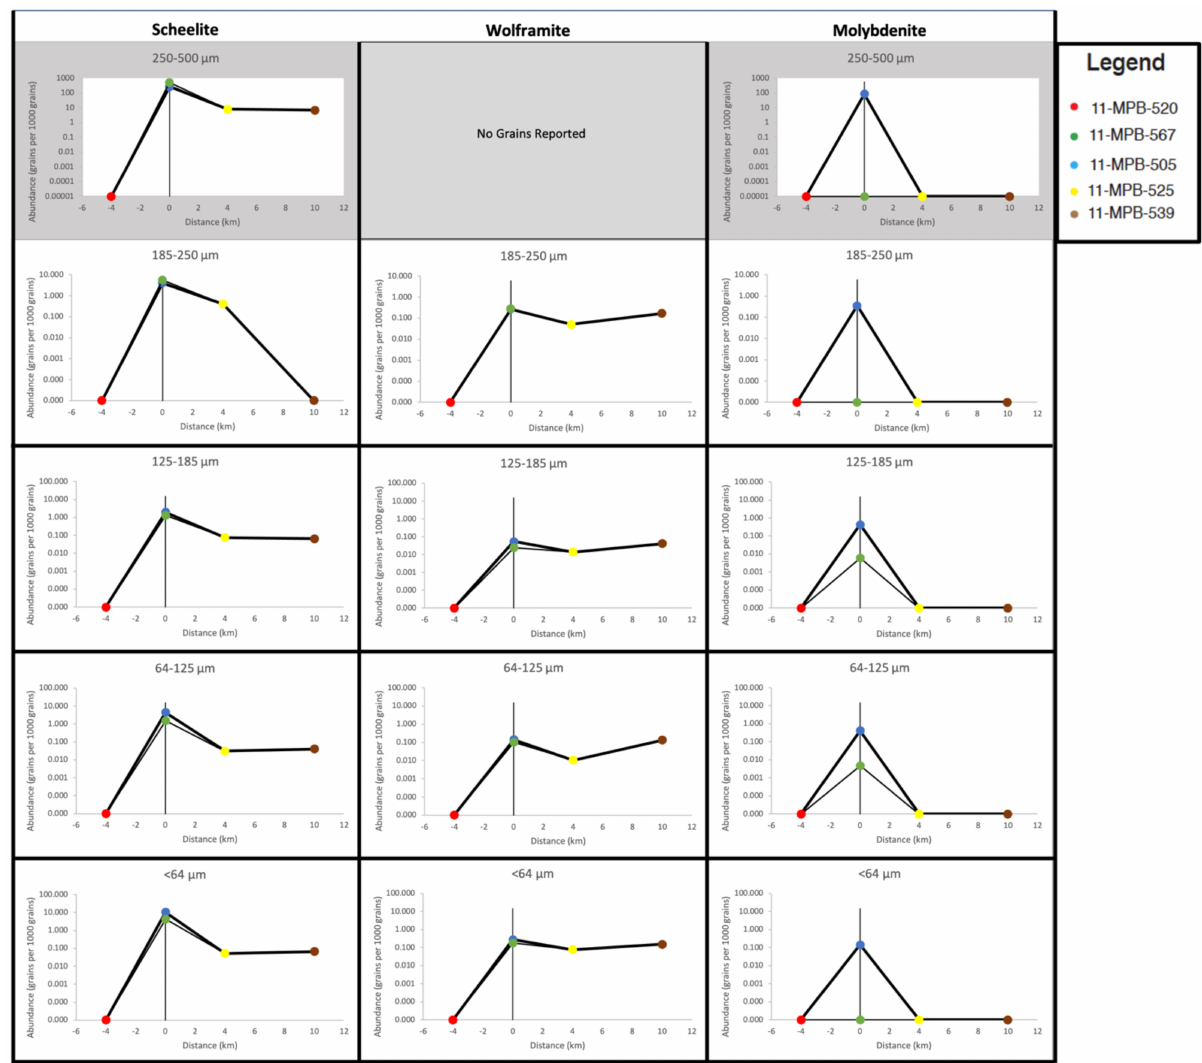
Figure 5. Grain abundance (normalized to grains per 1000 grains) of key ore minerals in the 185 to 250, 125 to 185, 64 to 125, and less than 64 µ m heavy-mineral concentrate (HMC) fractions (mineral liberation analysis; this study) of five samples from the Sisson deposit, New Brunswick (log-scaled, y-axis). The x-axis of each is a scaled representation in the direction of ice flow (black arrow). The location of mineralization is denoted by a grey line, and two trendlines depict the inferred decay in indicator mineral abundance along the dispersal train extending from the deposit, taking into account the two separate paths across mineralization (samples 11-MPB-505 and